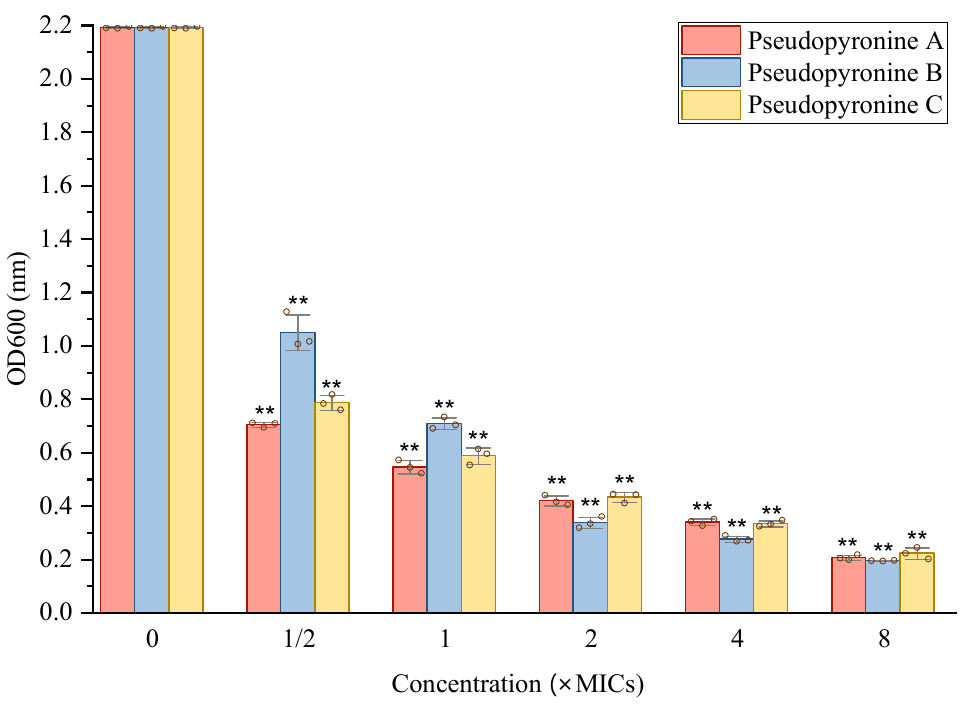
Figure 4. Reduction effects of sub-MIC concentrations of pseudopyronine A, B and C on mature biofilm of S. aureus . Data are presented as mean ± SD, n = 3, ** p < 0.01, compared to the control group.